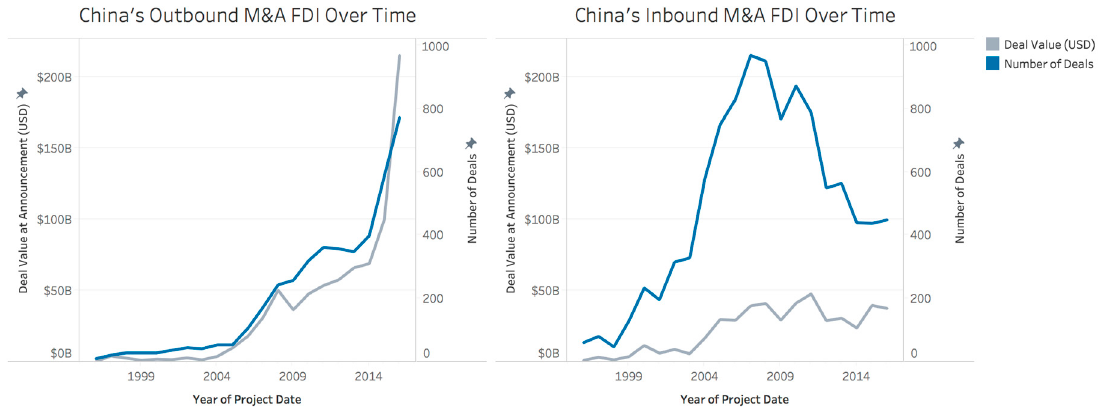
Figure 8. China’s outbound and inbound M&A investments. China’s reversal in M&A positioning is shown in terms of the number and amount of investment.